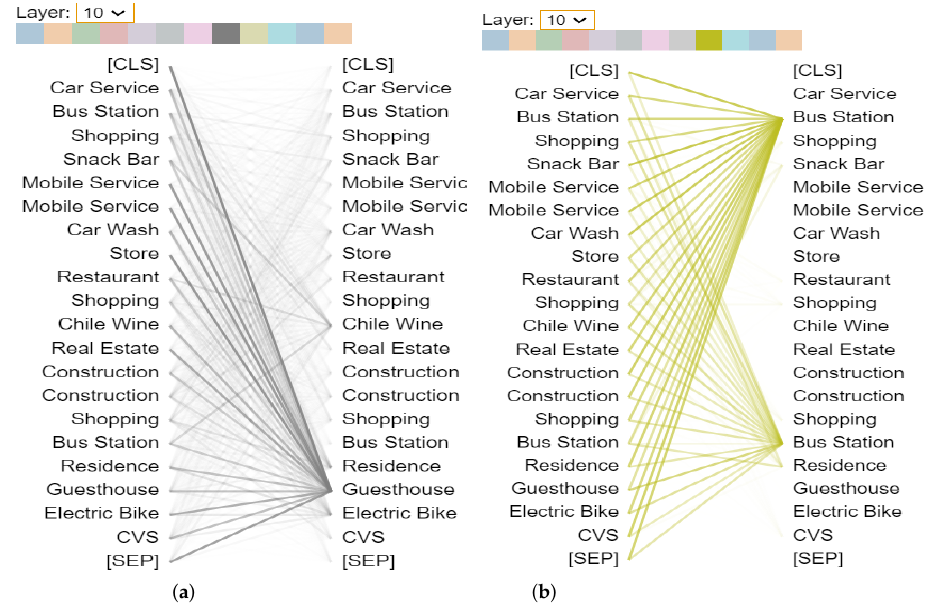
Figure 19. Attention Layer 10 (with all heads) of three models. Although “Mall’ and “Hotel” are in different positions in different corpora, they are successfully recognized by the models. As we have mentioned, the core ability of GeoBERT is to identify the most significant tokens in a grid and capture co-occurrence. These phenomena only appear in the deep attention layers, basically from Layer 9 to Layer 11 (layer index starts at 0).